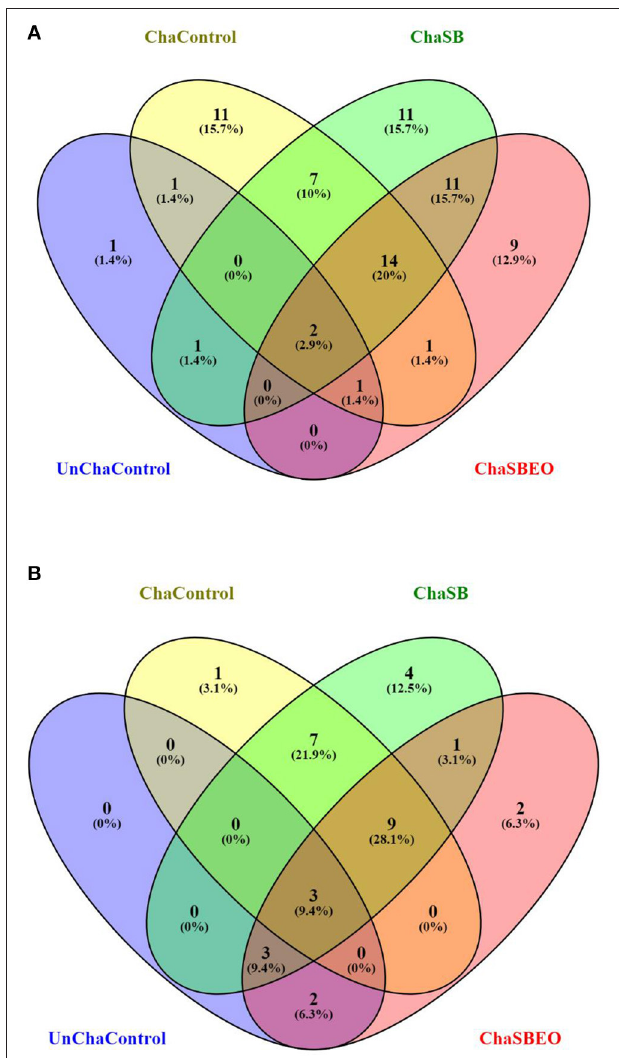
FIGURE 3 | Venn diagram of the up (A) and downregulated (B) predicted functions on d 21 compared to d 12 according to each experimental group. Absolute number represent the number of different predicted functions among the groups, followed by its respective percentage. SB, Sodium butyrate; SBEO, Sodium butyrate plus essential